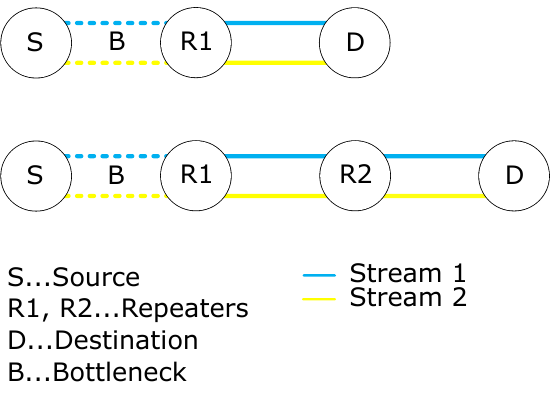
Figure 17. Simulation topology for balancing of two streams with one and two